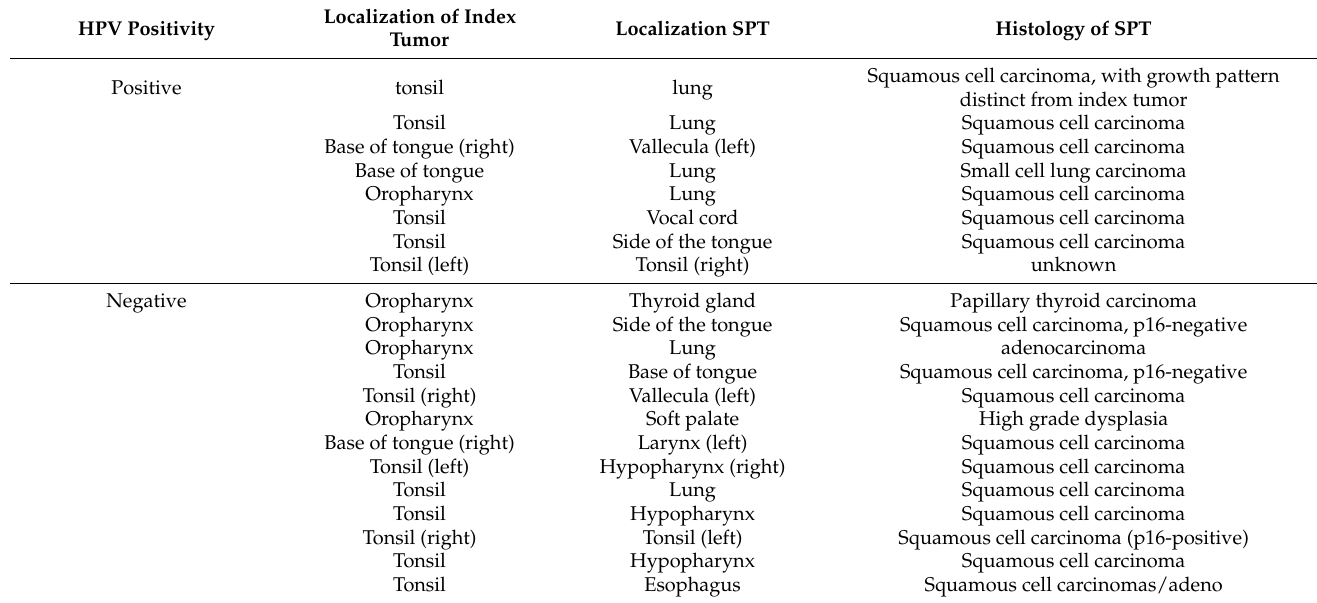
Table 7. Overview over localization and histological entity of the tumors of HPV-positive and HPV-negative patients who developed an